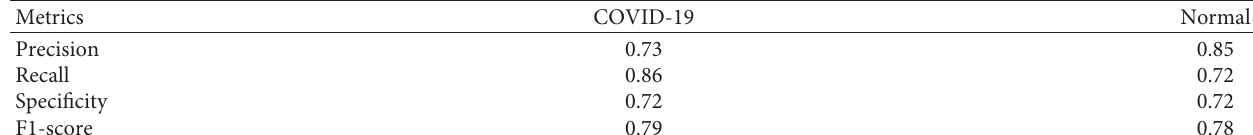
Table 6: Performance of VGG19 network based on CT